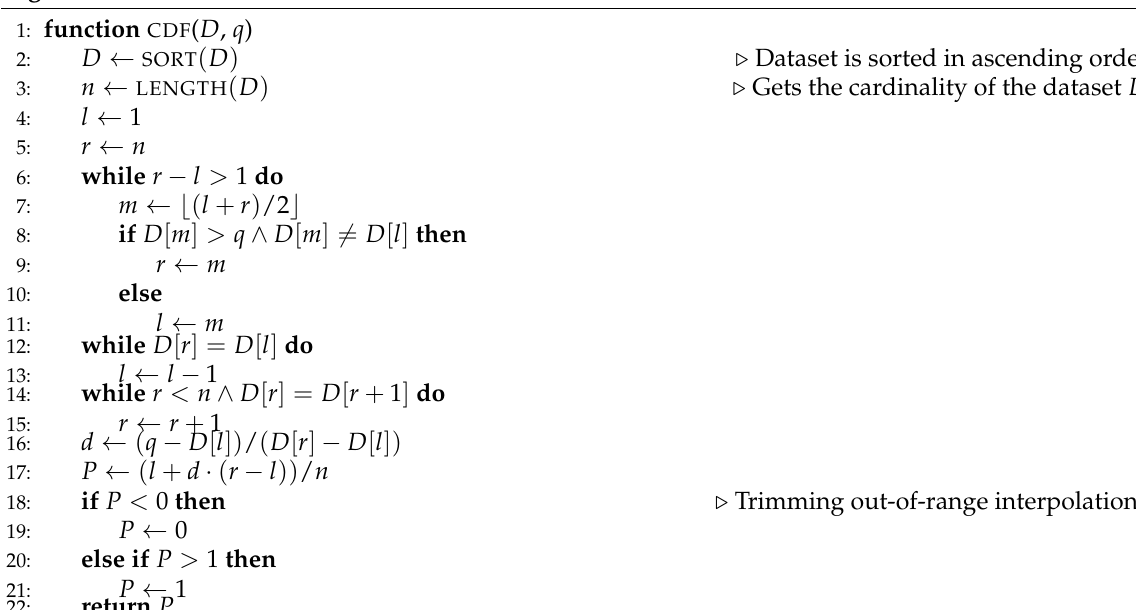
Algorithm 1 Cumulative distribution function